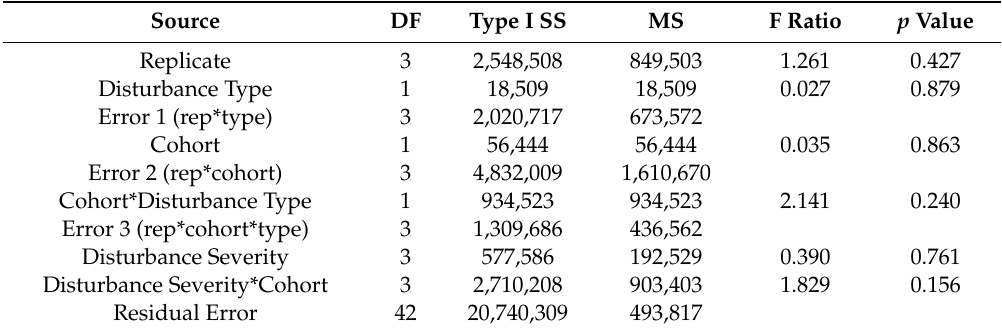
Table A3. Split-plot analysis of variance (ANOVA) table for annual aboveground wood net primary production (ANPP w ), presented in Figure 5 of the manuscript. Disturbance type and successional cohort (cohort) main e ff ects and their interaction were tested against more conservative error terms to account for restricted randomization, whereas the main e ff ect disturbance severity and its interaction with cohort were tested against the residual error. Asterisks indicate an interaction between two or more